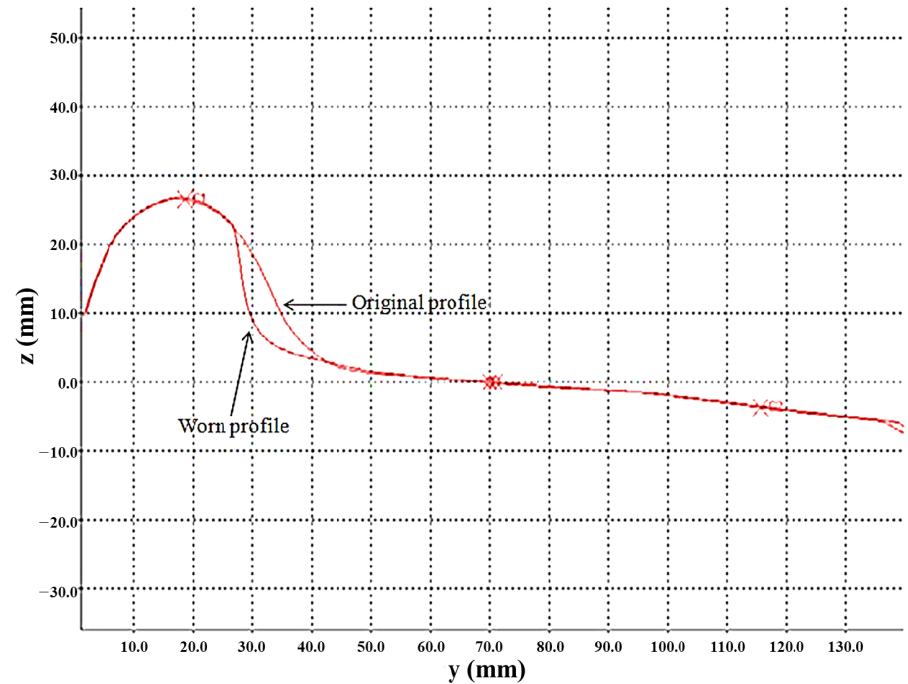
Figure 1. City train wheel experiencing severe wear.